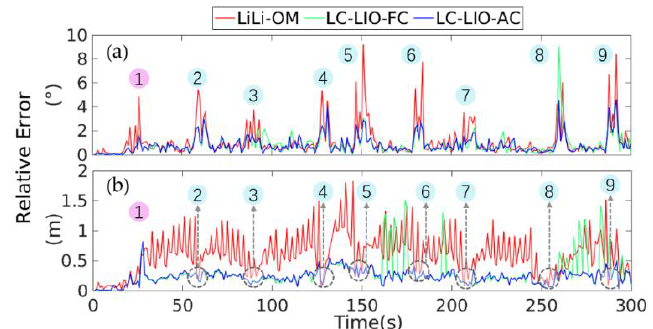
Figure 9. The RPE of LiLi-OM, LC-LIO-FC and LC-LIO-AC on the entire trajectory of one experiment in the urban canyon 1. The number corresponds to the nine places denoted in Figure 8a. ( a , b ) present RRE and RTE, respectively. The gray circles represent that the RTE of the three methods are comparable as the vehicle moves slowly at the turns.